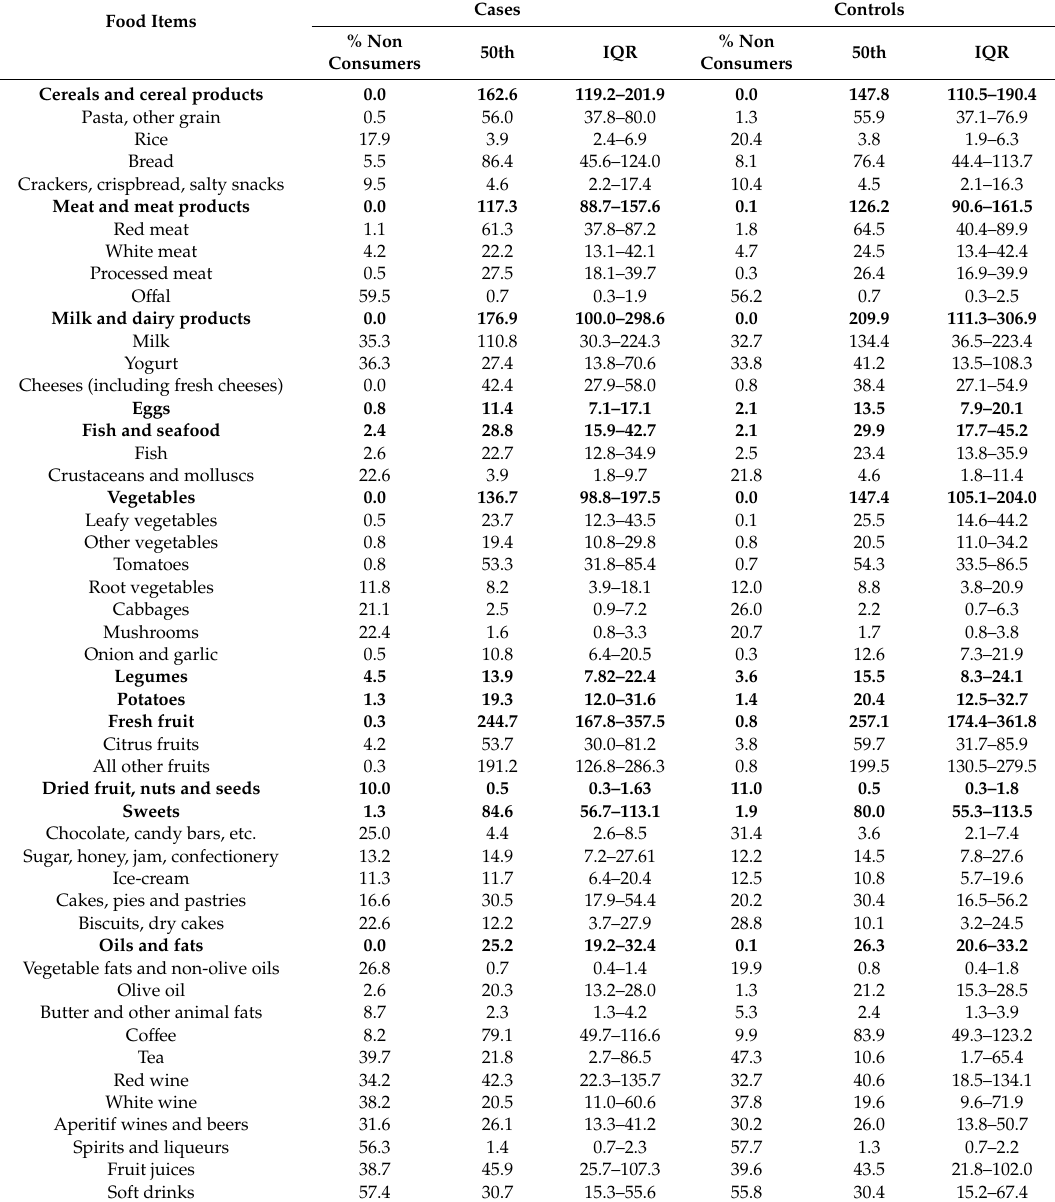
Table 2. Daily intake (g / day) of di ff erent food items or categories for cases and controls. Median (50th) and interquartile range (IQR) values calculated only in